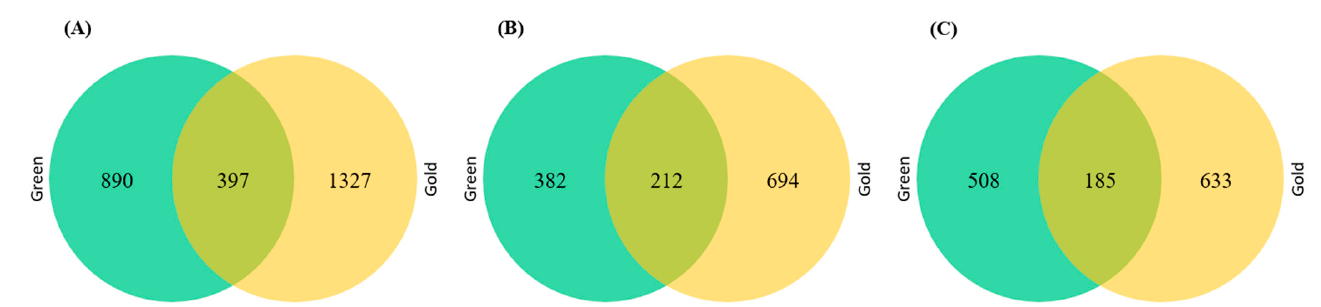
Figure 4. Venn diagram showing the number of differentially expressed genes (log 2 fold change equal or greater than 1 and p < 0.05) total ( A ), upregulated ( B ), and downregulated ( C ), between green ‘Hayward’ and gold ‘Haegeum’ kiwifruit cultivars after 3 days of ripening with ethylene treatment or without ethylene treatment (control) at 25 °C.